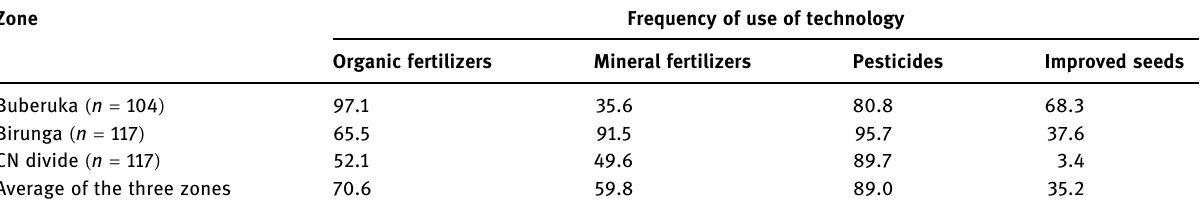
Table 1: Percentage of households using productivity enhancing technologies in the three major fertilizer consuming agroecological zones in Rwanda Zone